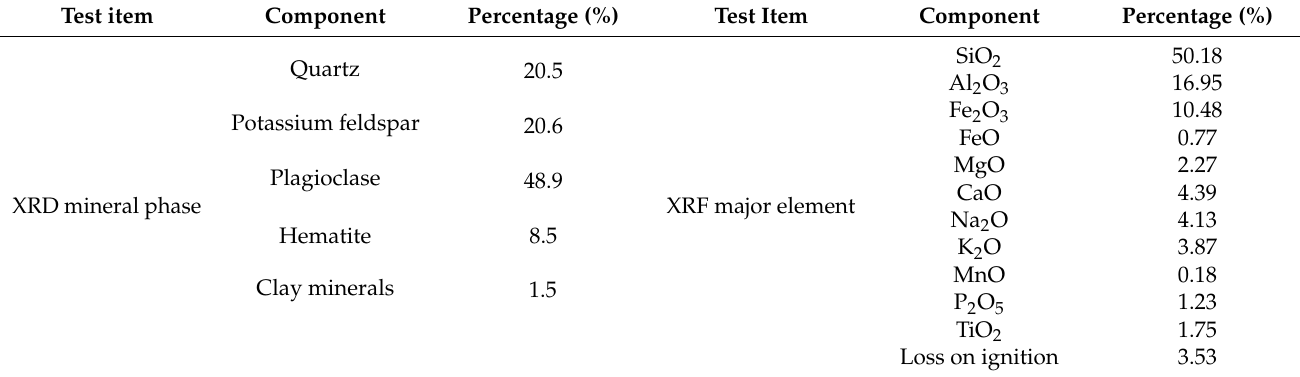
Table 1. Proportions of primary minerals and major oxides for samples.